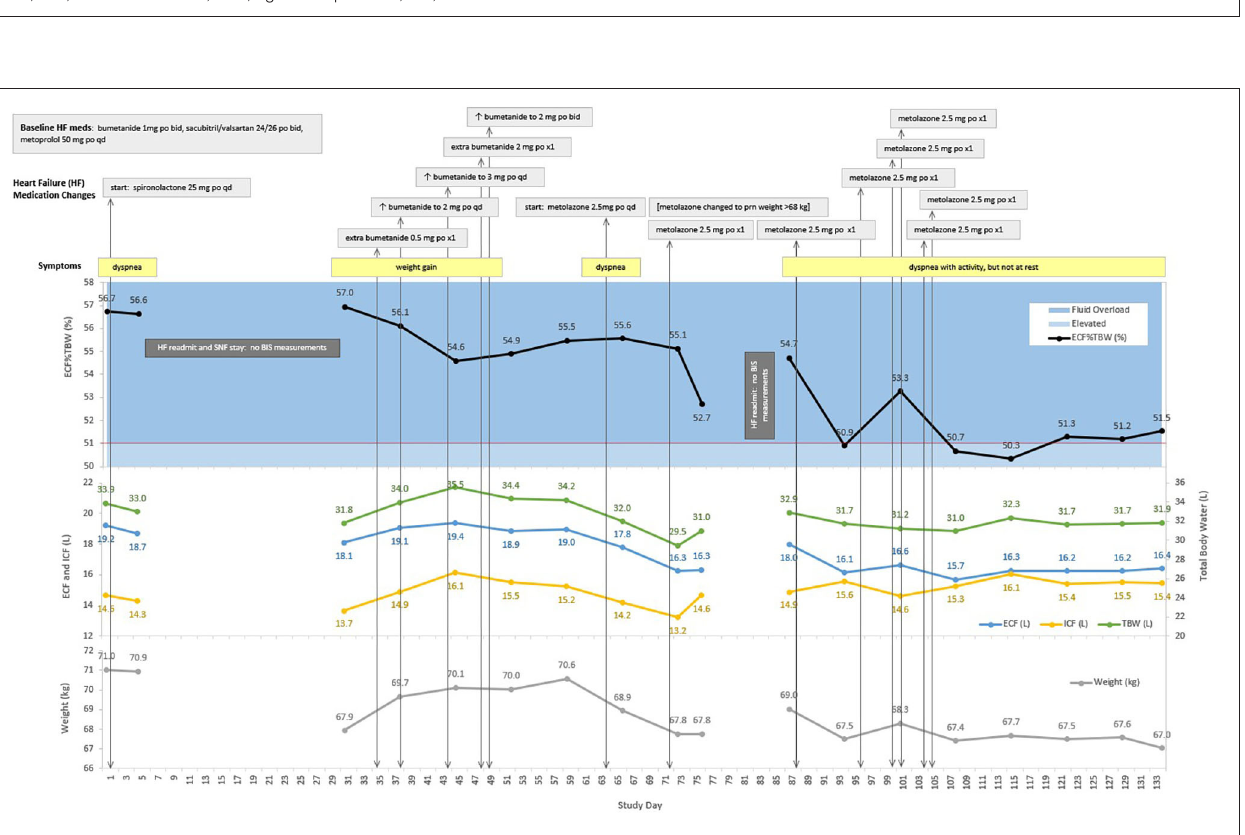
FIGURE 5 | Case Study: 87 year-old man with two heart failure readmissions. ECF, extracellular fluid; ICF, intracellular fluid; TBW, total body water; ECF%TBW, extracellular fluid as a percentage of total body water; mg, milligram; po, oral; qd, daily; L, liters; kg, kilograms; BIS, bioimpedance spectroscopy; SNF, skilled nursing facility. The red line at 51% ECF%TBW indicates the transition from elevated fluid volume to fluid overload.